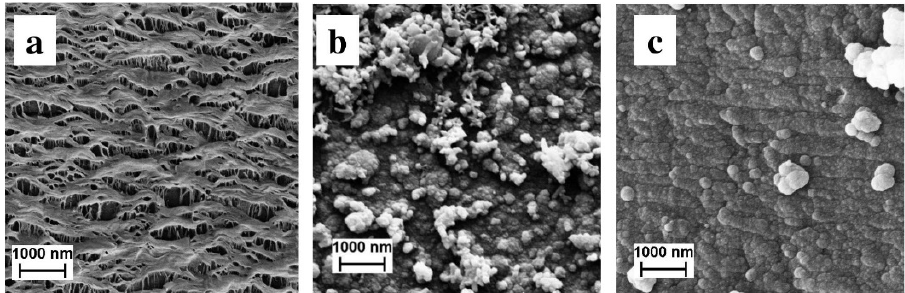
Figure 5. SEM micrographs (surface) of porous support ( a ), composites (porous support/PANI coating) ( b ), and (porous support/PPy coating) ( c ). Table 3. Characteristics of the composites porous support/electroactive